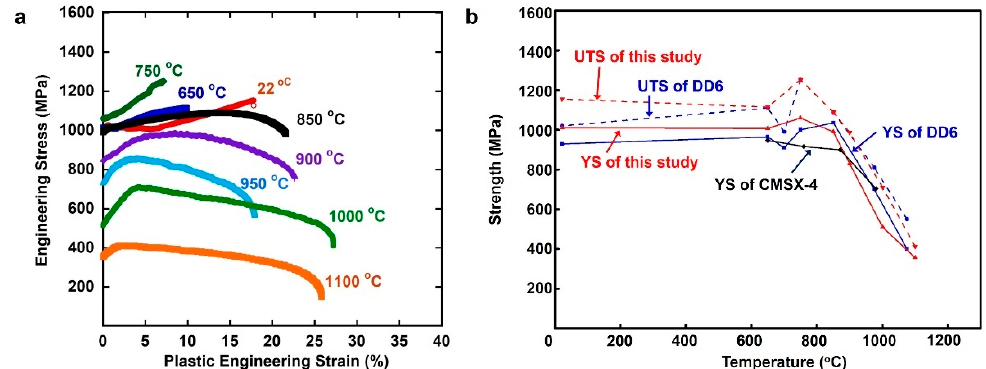
Figure 8. Tensile properties of the Ni-based single crystal (SX) superalloy at different temperatures. ( a ) Engineering stress–strain curves. ( b ) Yield strength (YS) and ultimate tensile strength (UTS) of the tested alloy and other second-generation Ni-based SX superalloys. Data of DD6 and CMSX-4 are taken from [32,37].